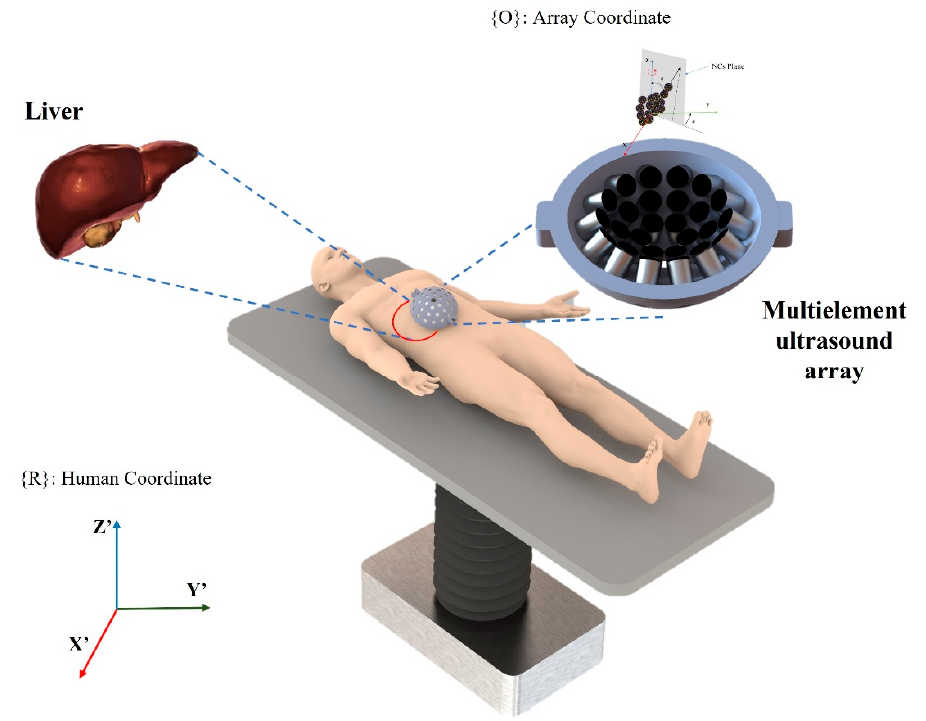
Figure 1. Concept image of AcoMan for controlling micro/nano carriers for targeted drug delivery in the liver. Nanoparticles are aggregated into clusters at trapping position so that they can move in unison; subsequently, they are driven in five DoFs by UTs array. Drugs are released by an external stimulus after the NCs reach the target area.